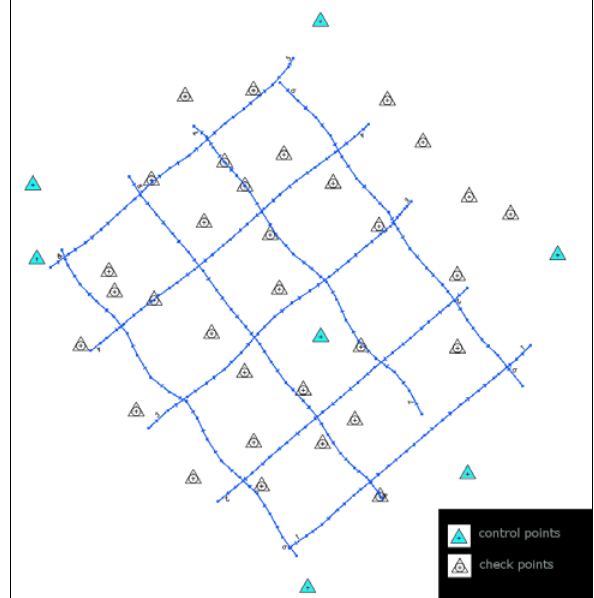
Figure 6: Flight pattern with distribution of